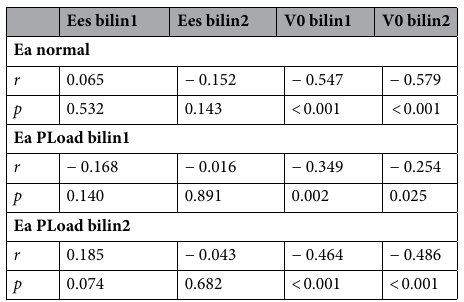
Table 2. Pearson’s correlation (r) between the mean Ees and V0 values and the mean maximally generated elastance values (Ea) before intervention (normal) and at the end of the different afterload intervention phases (Ea PLoad bilin 1 and 2) in all animals.